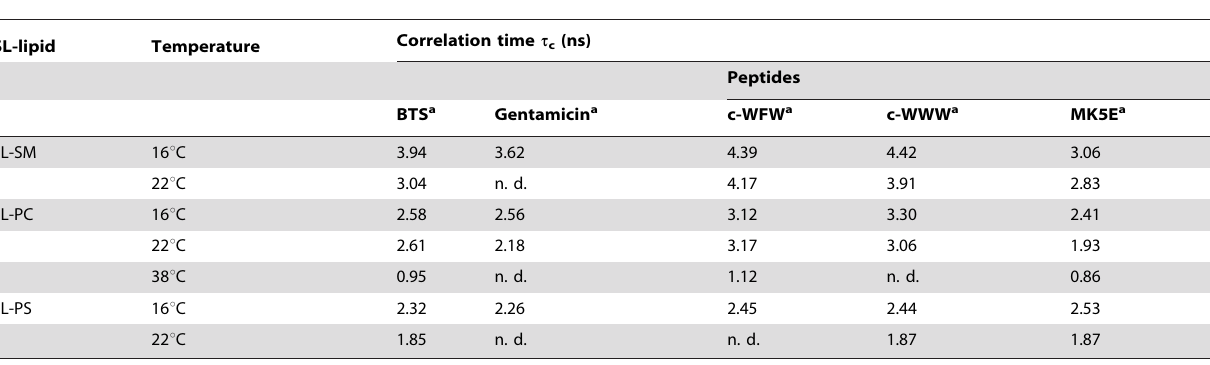
N -(4-doxylpentanoyl)- trans -sphingenyl-1-phosphocholine (SL-SM). 1-Palmitoyl-2-(4-doxylpentanoyl)-phoshatidylcholine (SL-PC). 1-Palmitoyl-2-(4-doxylpentanoyl)-phosphatidylserine (SL-PS). not determined (n. d.). a Values are means calculated from spectra of four independent sperm samples (SD , 0.05).